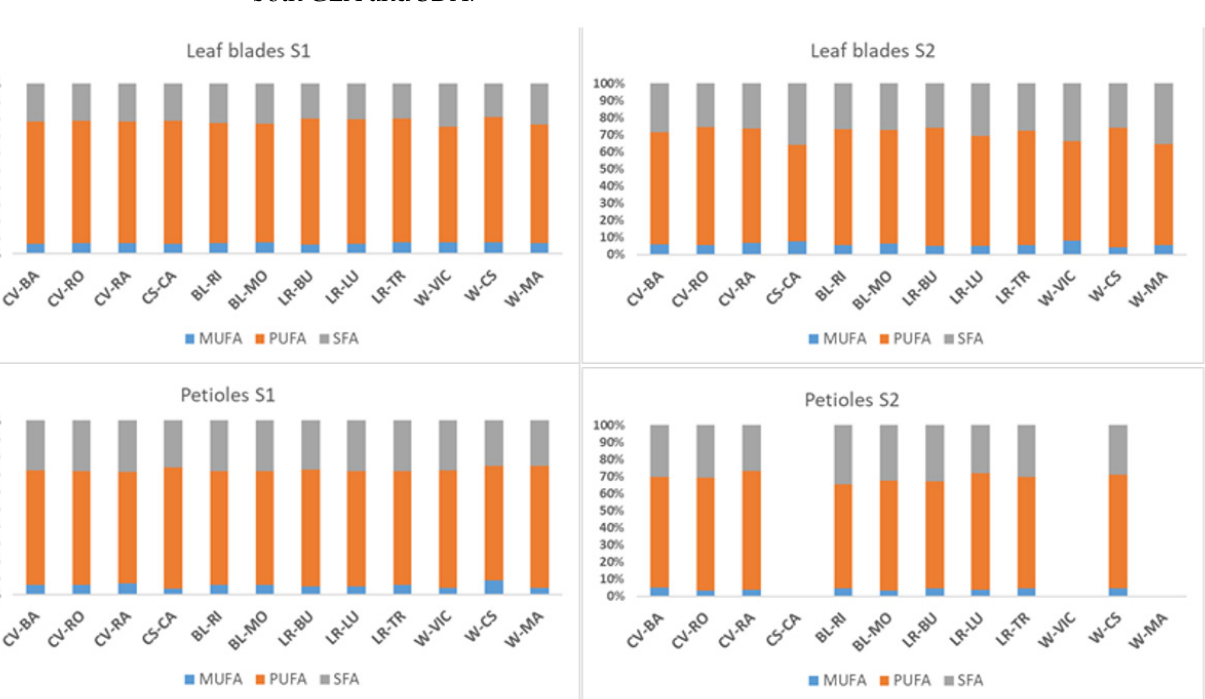
Figure 2. Polyunsaturated fatty acids (PUFA), Monounsaturated fatty acids (MUFA) and Saturated fatty acids (SFA) dis- tribution, expressed as percentage, in borage limbs and petioles sampled at 120 days after sowing (S1) and 150 days (S2) of 12 borage accessions (see Table 1). Samples without values mean sessile leaves at this plant-growing period.